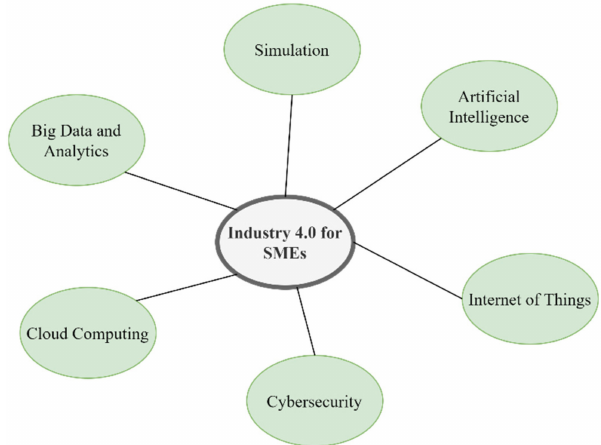
Figure 4. Industry 4.0 scheme for SMEs.